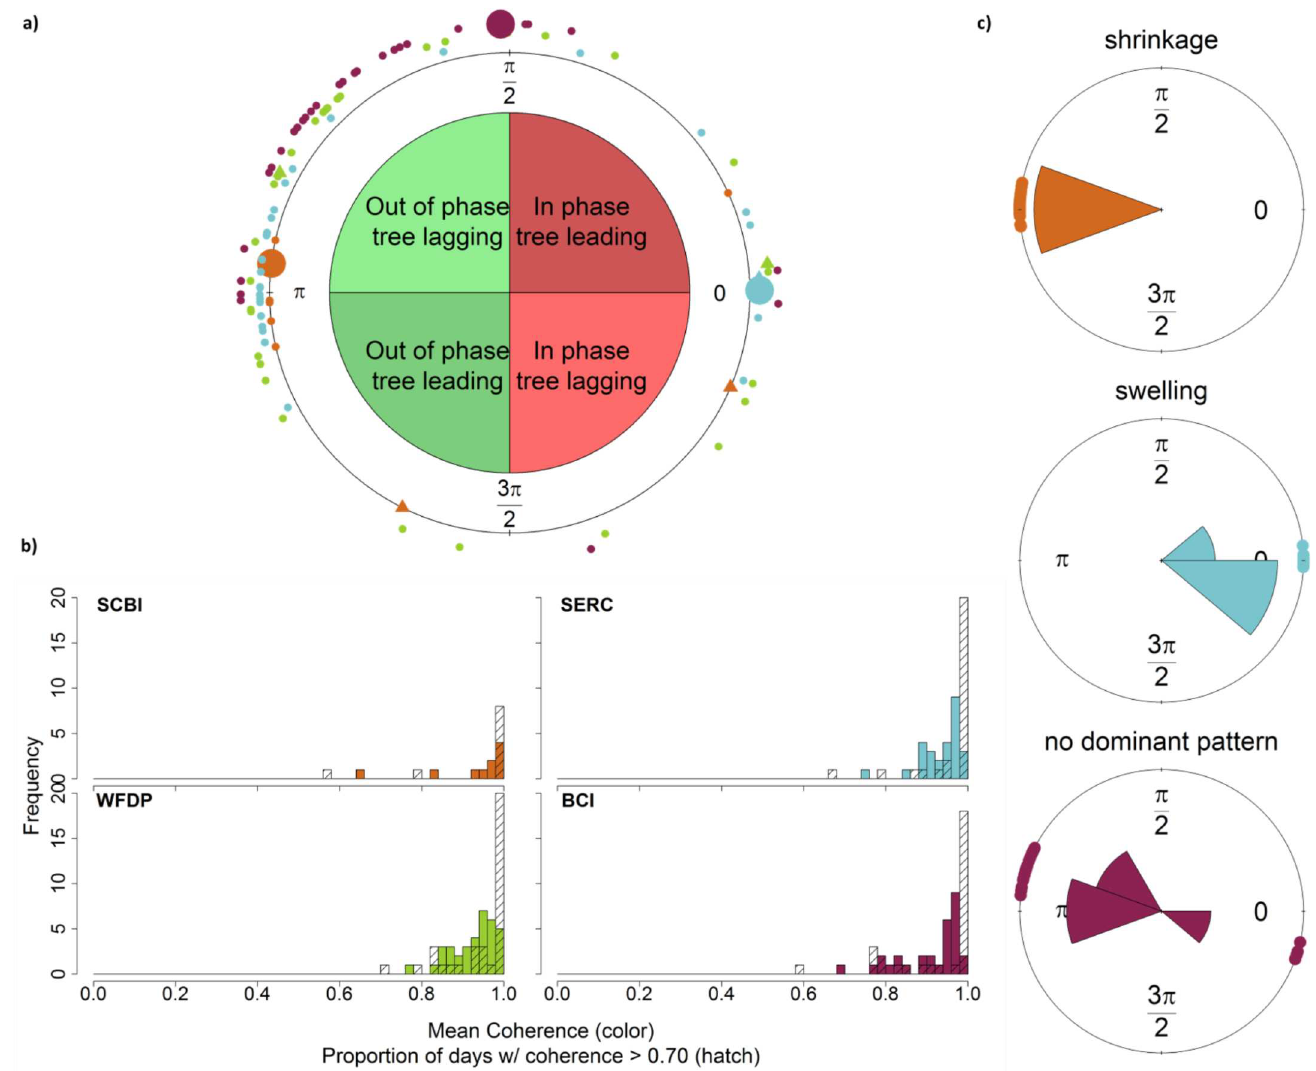
Fig 5. Daily patterns of tree circumference change in relation to temperature. (a) Diagramshowingmean phaseangle θ for all trees (circles: live trees; triangles: deadtrees), where π /2 < θ < 3 π /2 indicatesshrinkageand θ < π /2 or θ > 3 π /2 indicatesswelling;(b) Histograms of mean coherence (colored bars) and proportionof days with coherence greater than 70% (hatchedbars); (c) examplesof daily (as opposedto mean) phaseangles ( θ day ) for individualtrees, correspondingto larger symbols in (a). Examples includea tree with shrinkageon (cid:21) 75% of days ( Liriodendron tulipifera , DBH = 49.3 cm, SCBI), one with swelling (cid:21) 75% of days ( Liriodendron tulipifera ,DBH = 69.3, SERC), and one with no consistentpattern ( Hura crepitans , DBH = 67.1 cm, BCI). For all 3 panels site-colors correspondencesare given in